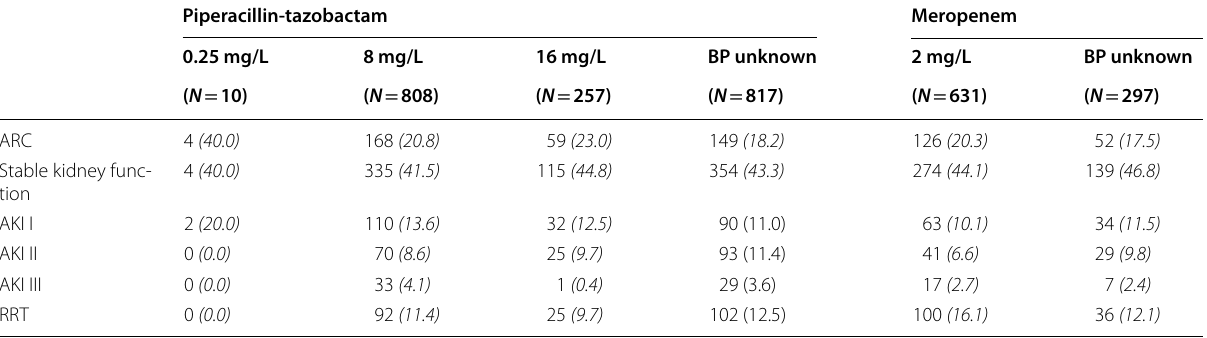
BP Break point , ARC Augmented renal clearance , AKI Acute kidney injury , RRT Renal replacement therapy